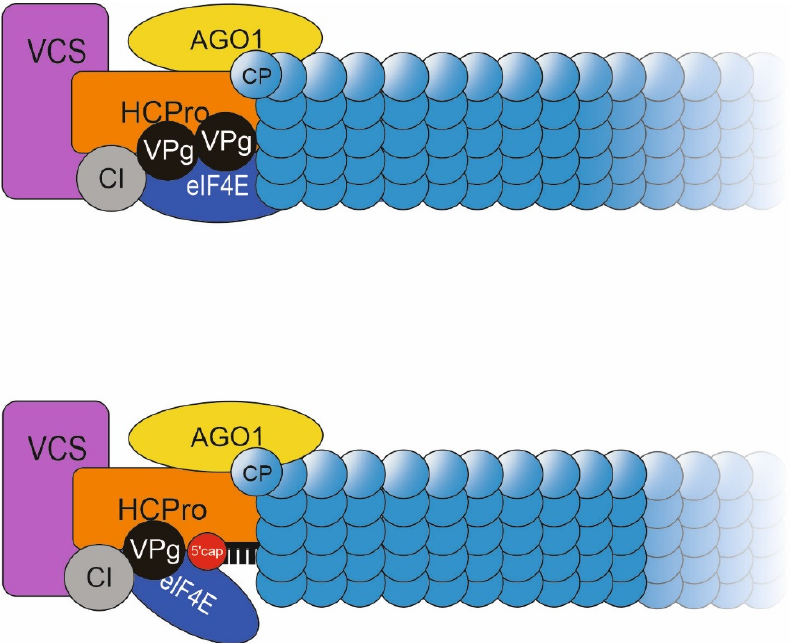
Figure 9. A hypothetical model for the formation of stable PVA particles. ( Top ): PVA WT particle with a high-molecular weight ribonucleoprotein complex assembled around VPg covalently bound at the 5 (cid:48) end of vRNA. The model incorporates known interactions between HCPro and VPg, CI, eiIF(iso)4E, VCS and AGO1 and CP. ( Bottom ): A PVA ∆ GDD -derived particle where the m7G cap replaces the covalently-bound VPg at the 5 (cid:48) end thus leaving the vRNA exposed to host